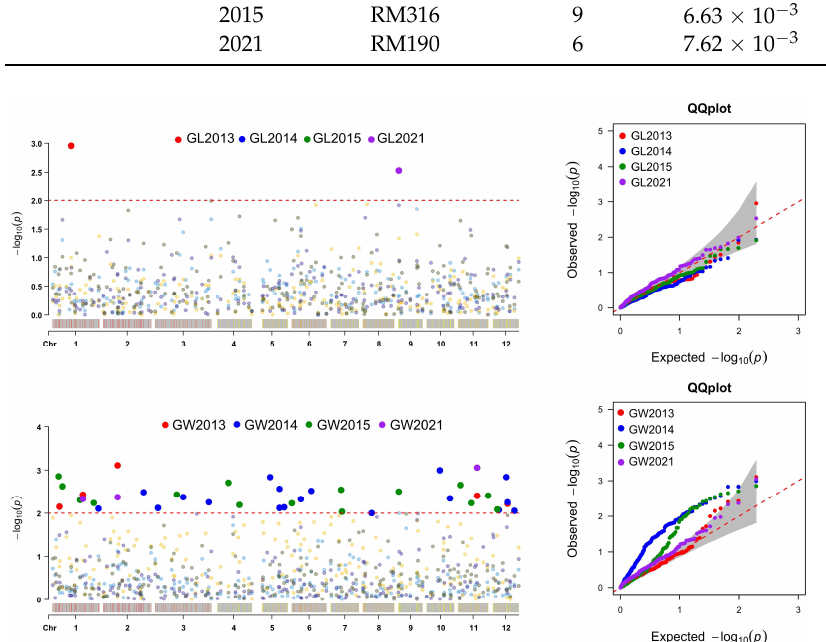
Figure 4. Manha(cid:308)an plots and quantile–quantile (QQ) plots for grain-size traits based on the MLM model. For the Manha(cid:308)an plot, the x-axis presents the 12 rice chromosomes and the y-axis the LOD (−log( p -value)) values. For the QQ plot, the x-axis presents LOD (−log( p -value)) values and the y- axis the expected LOD (−log( p -value)) values.